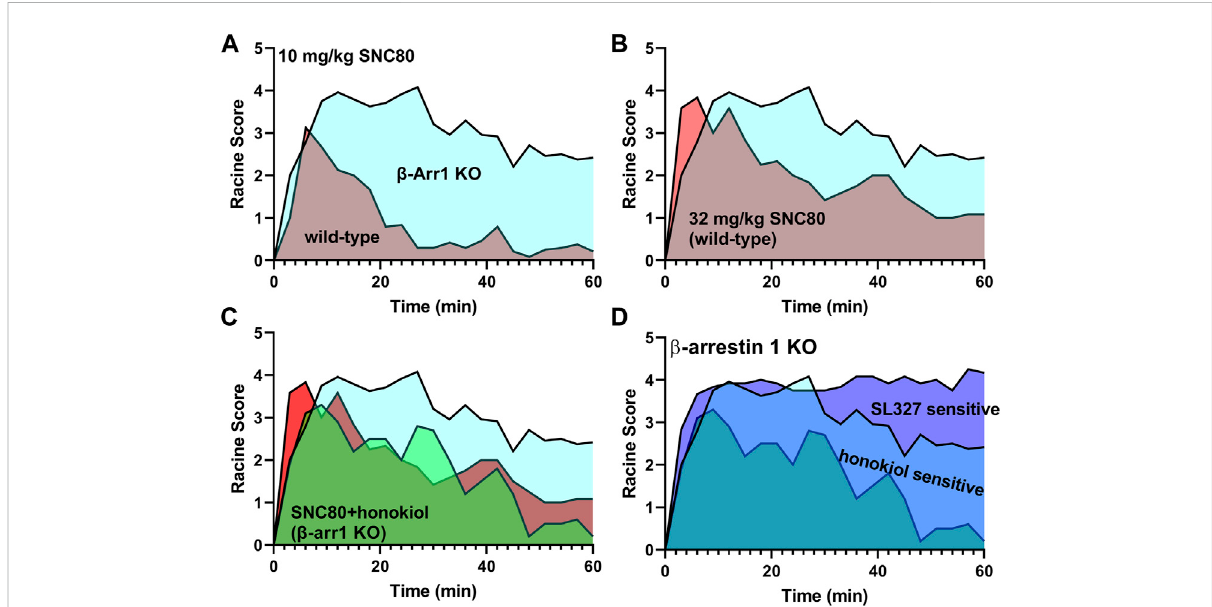
FIGURE 8 Enhanced δ OR-agonist induced seizures in β -arrestin 1 knockout mice are modulated by ERK and AKT inhibition, while those kinases are not part of δ OR-induced seizures in wild-type mice. 10 mg/kg SNC80 produces more severe seizures in β -arrestin 1 knockout mice compared to wild- type mice (A) . 32 mg/kg SNC80 in wild-type mice produces clonic seizures (Racine score 4), similar to 10 mg/kg SNC80 in β -arrestin 1 knockout mice, but the intensity tapers off more rapidly in wild-type mice (B) . Inhibition of PI3K/AKT reduces seizure effects for 10 mg/kg SNC80 in β